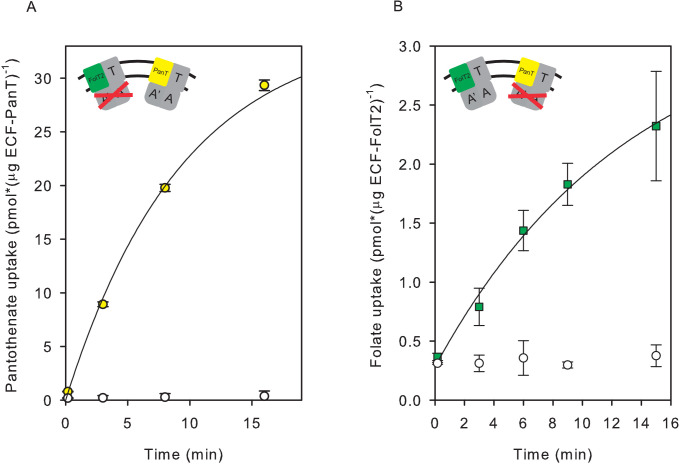
Control experiments for the ones shown in Figure 4, now with the two substrates swapped.(A) Pantothonate uptake into proteoliposomes co-reconstituted with ECF-PanT and ECF(E-to-Q)-FolT2, containing 10 mM Mg2+-ATP (yellow circles) or Mg2+-ADP in the lumen (white circles), respectively. (B) Folate uptake by into proteoliposomes co-reconstituted with ECF-FolT2 and ECF(E-to-Q)-PanT, containing 10 mM Mg2+-ATP (green squares) or Mg2+-ADP (white circles) in the lumen, respectively. Error bars indicate standard deviation of triplicate measurements.